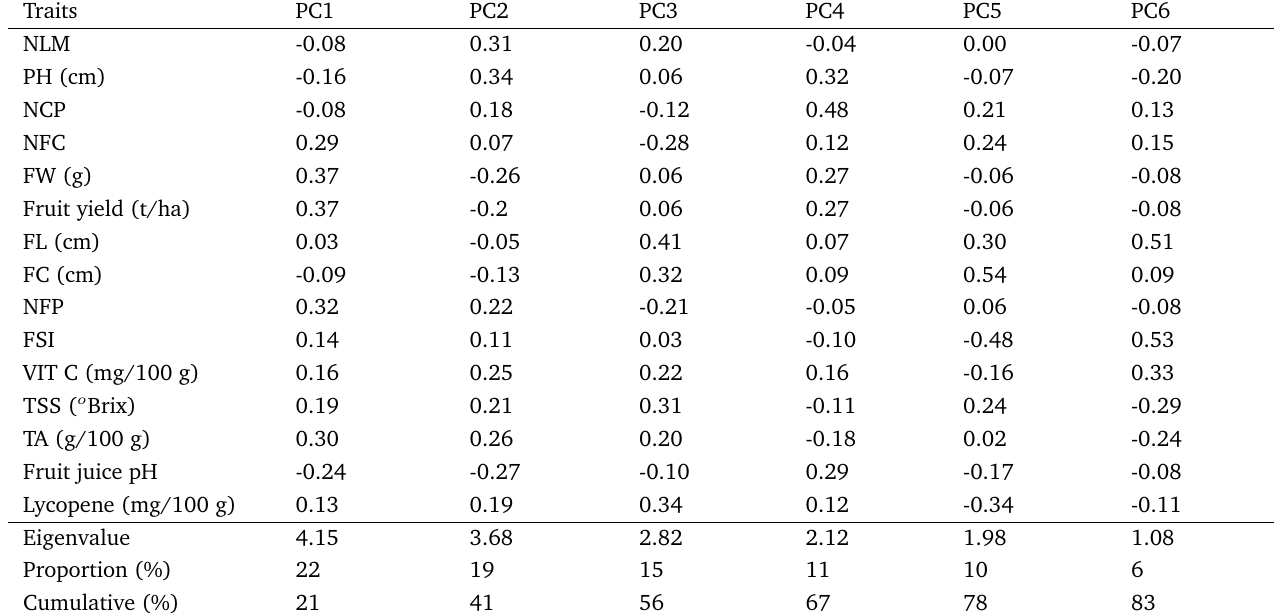
Table 6. Eigenvalue, proportion of variability and estimated traits of wild tomato accessions contributing to first six principal components